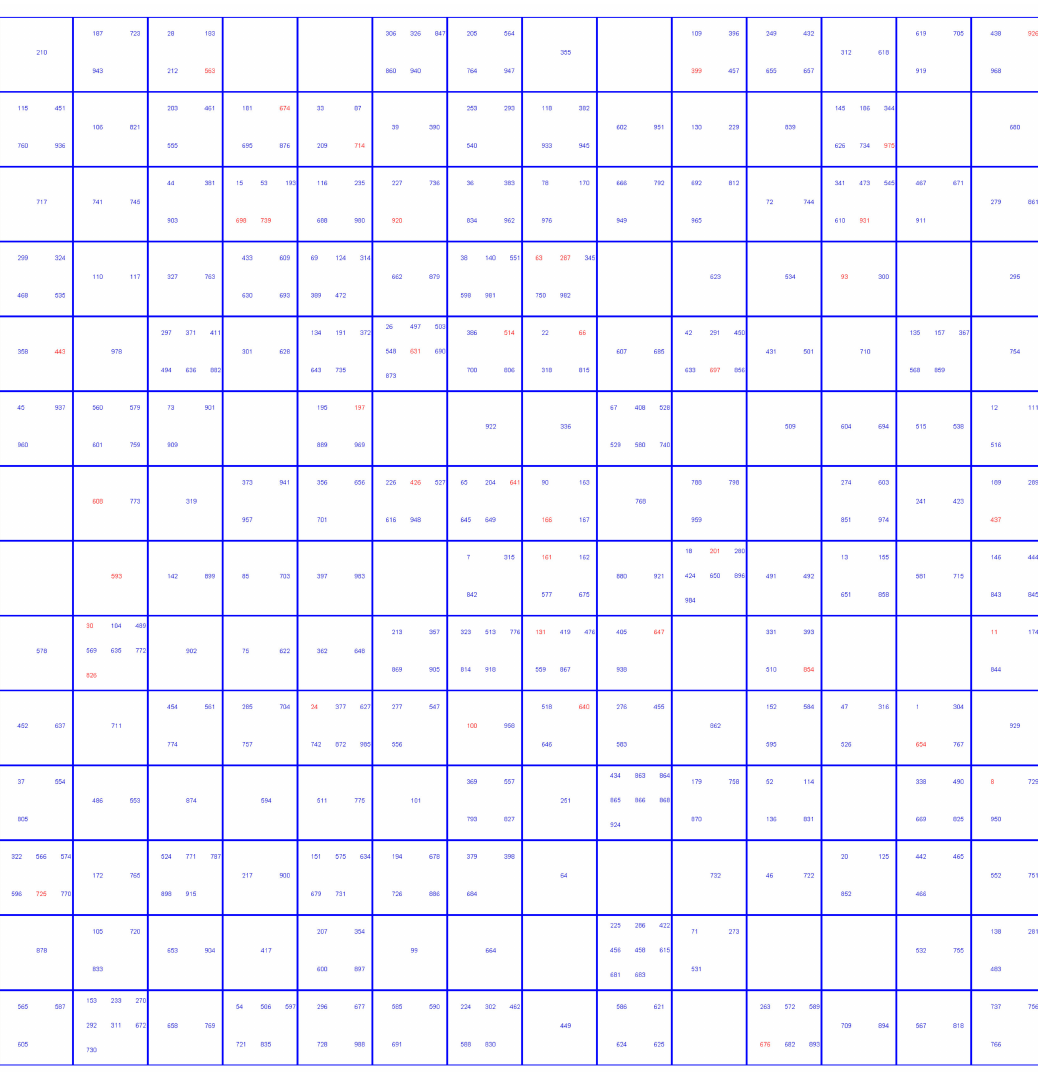
Figure 3. Selection of validation set compounds for the second approach using the Kohonen